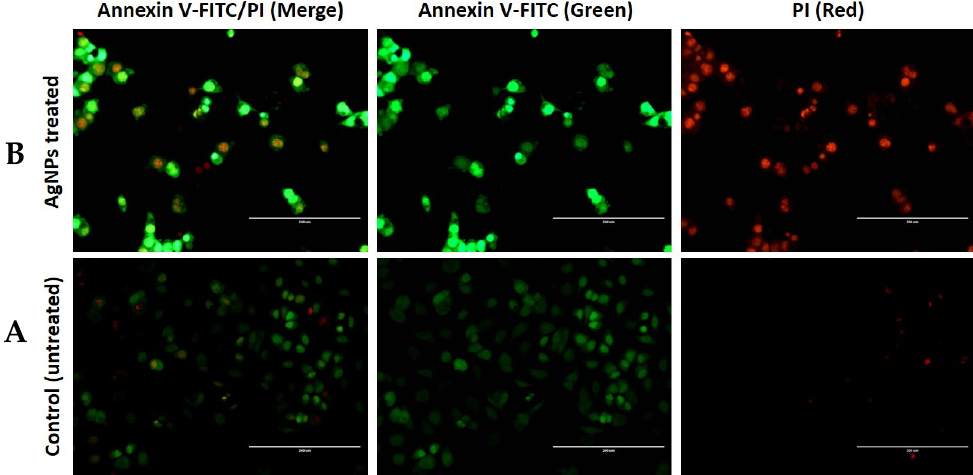
Figure 10. Manufactured Asf-AgNPs induced apoptosis of MCF7 cells as established through phosphatidylserine translocation using a fluorescent microscope. Control cells displayed no Annexin V-FITC/PI staining ( A ). Cells treated with Asf-AgNPs (IC 50 40 µg/mL at 48 h) showed double staining of Annexin V-FITC/PI, indicating apoptosis ( B ).